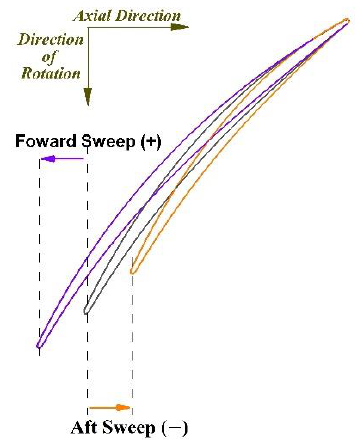
Figure 4. The definition of inducer blade sweep at tip section.